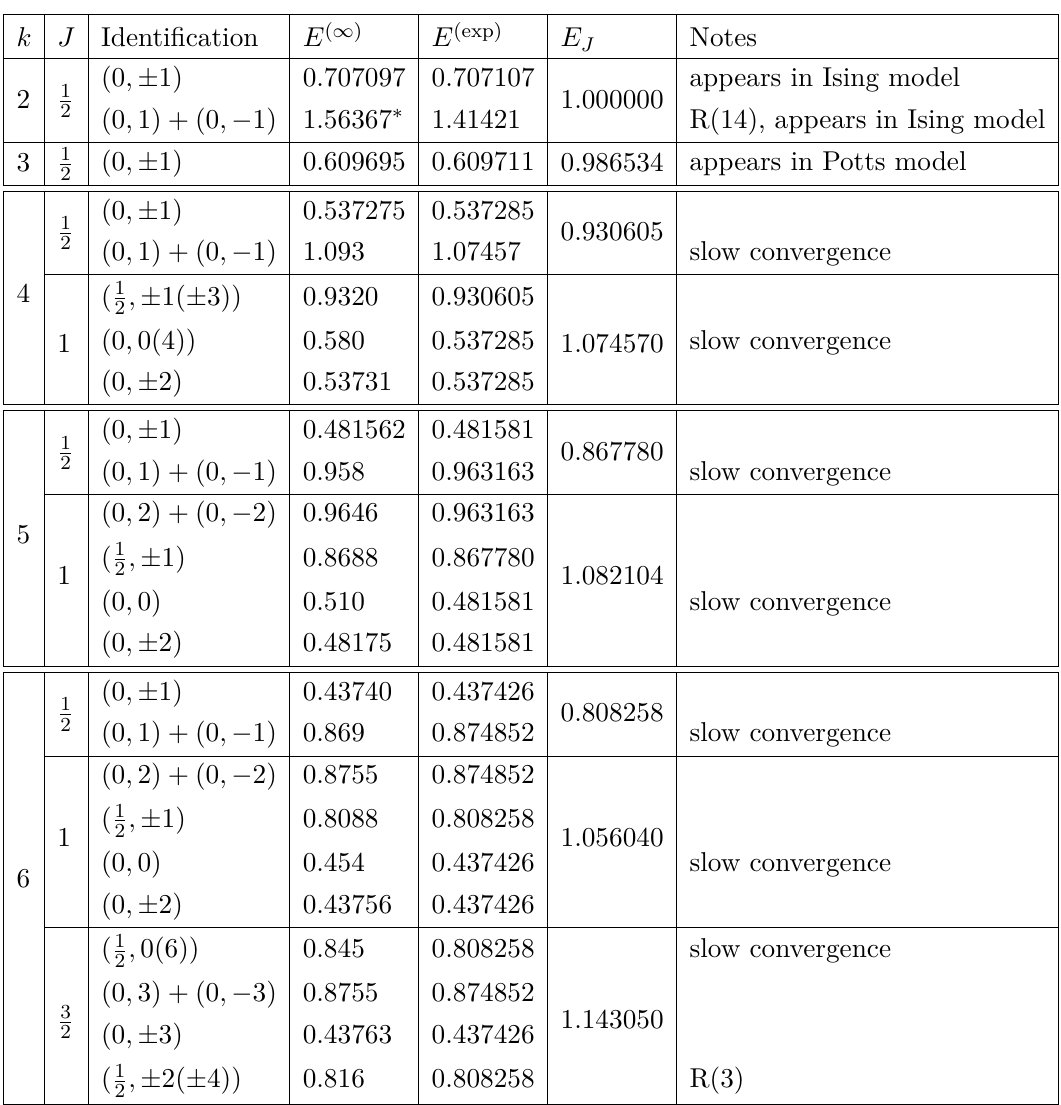
Table 10 . List of solutions in SU(2) k WZW models with k ≤ 8 describing SU(2) Cardy boundary states, part 1. The result are grouped according to the level k and then by the boundary condition J . We show the most likely identification of solutions, comparison of extrapolated energies E ( ∞ ) with their expected values E (exp) and with energy of the background E and sometimes additional J